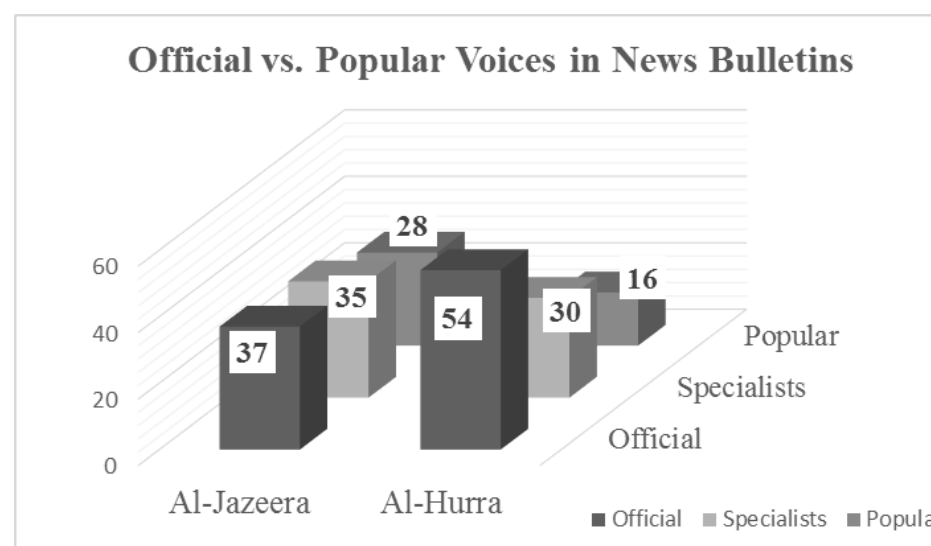
Figure 6. The popular vs. the official voices in news bulletins’ guests. 4